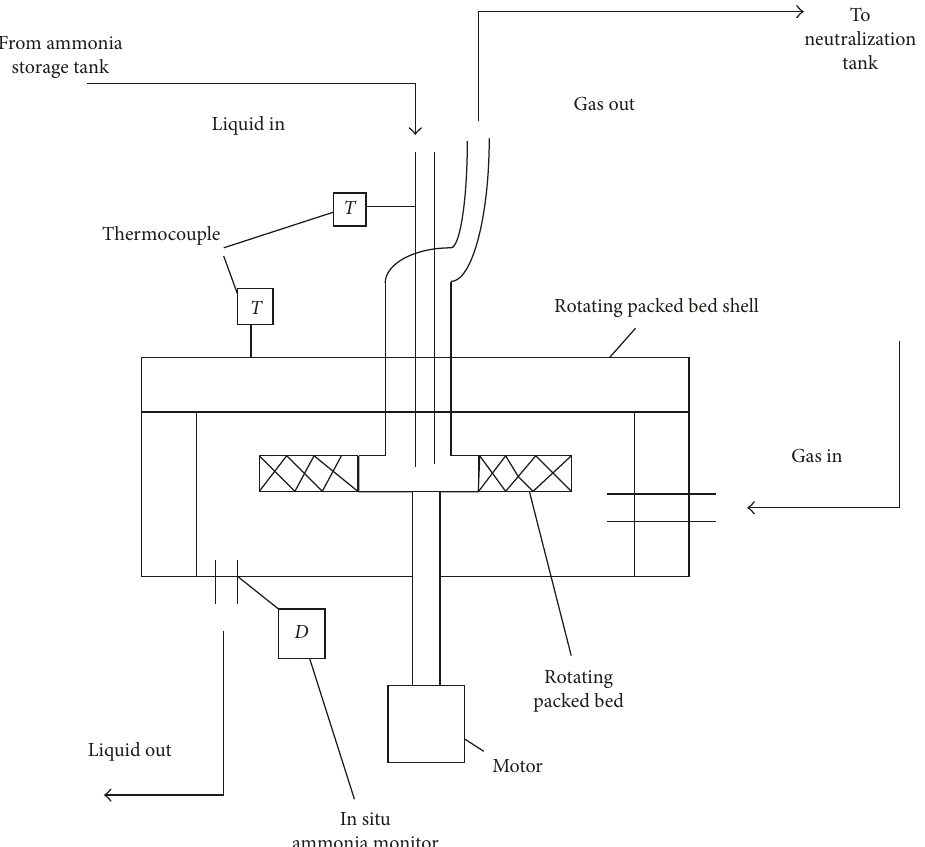
Figure 6: Rotating packed bed reactor configuration for ammonia